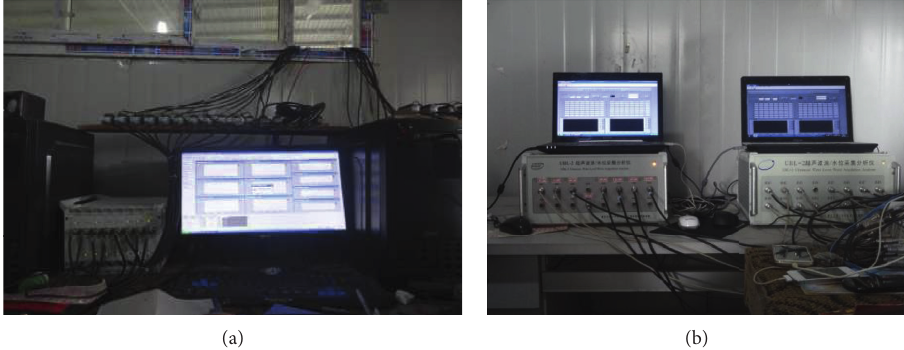
Figure 5: Wave pressure acquisition system in test. (a) Wave pressure acquisition and (b) water level acquisition.